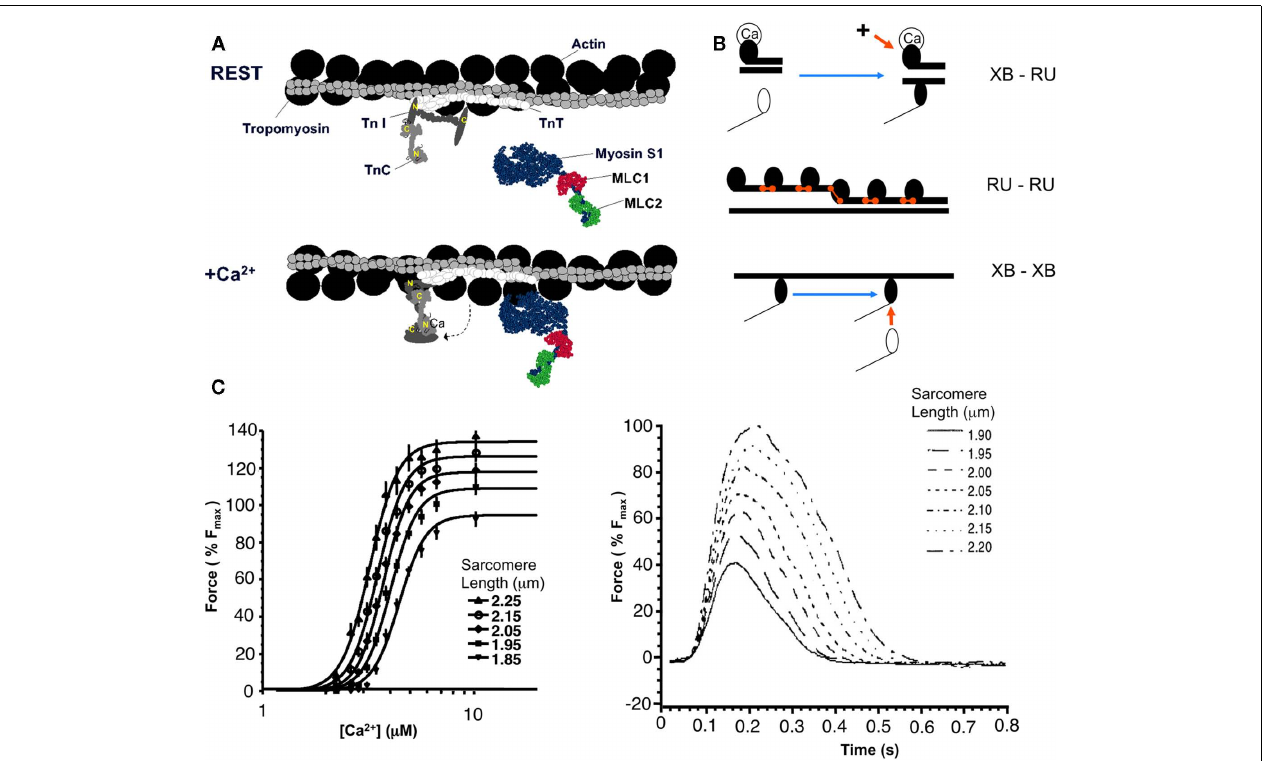
the associated RU; RU–RU shows that RU units are connected (red link) that promotes similarity with the two neighbors; and XB–XB shows that a bound XB increases the binding rate of a neighboring XB. (C) Figure shows the SL dependence of isometric responses. Left panel : average force–Ca 2 + relationships (pooled data, skinned rat cardiac trabeculae, n = 10) at five SLs; data are fitted to a Hill relationship.The level of cooperativity, assessed by the Hill coefficient, is essentially not affected by SL (from Dobesh et al., 2002, with permission). Right panel : effect of SL on force during twitches. Different traces show normalized different SLs (in micrometers) as indicated in key. Force is normalized so that maximal force corresponds to a value of 1.0. As SL increases, the peak force increases, while the time to peak is mostly constant. In additions, the relaxation phase is slowed so that the total twitch duration is an increasing function of SL. (from Janssen and Hunter, 1995, with